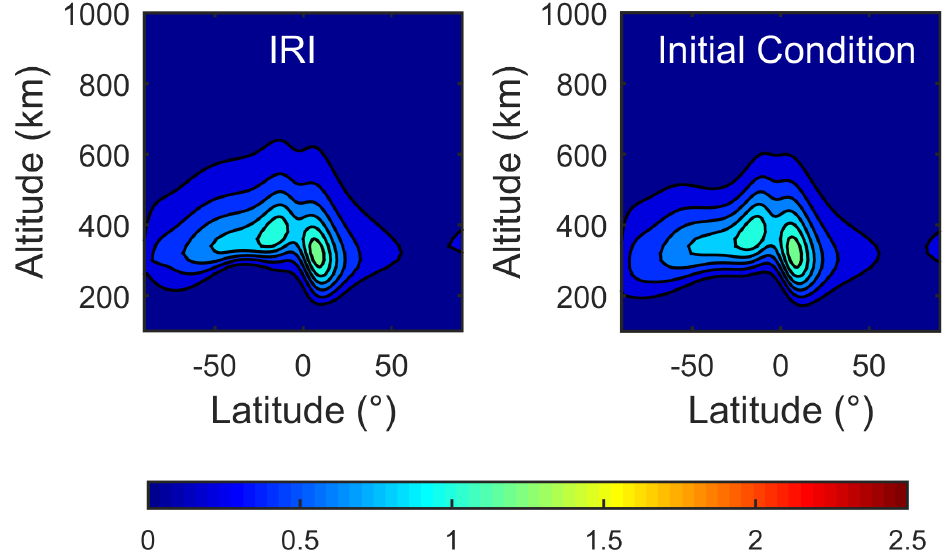
Figure 2 - Electron density obtained from IRI2012 in the left panel and Chapman adjustment to be used as initial condition for ART and MART in the right